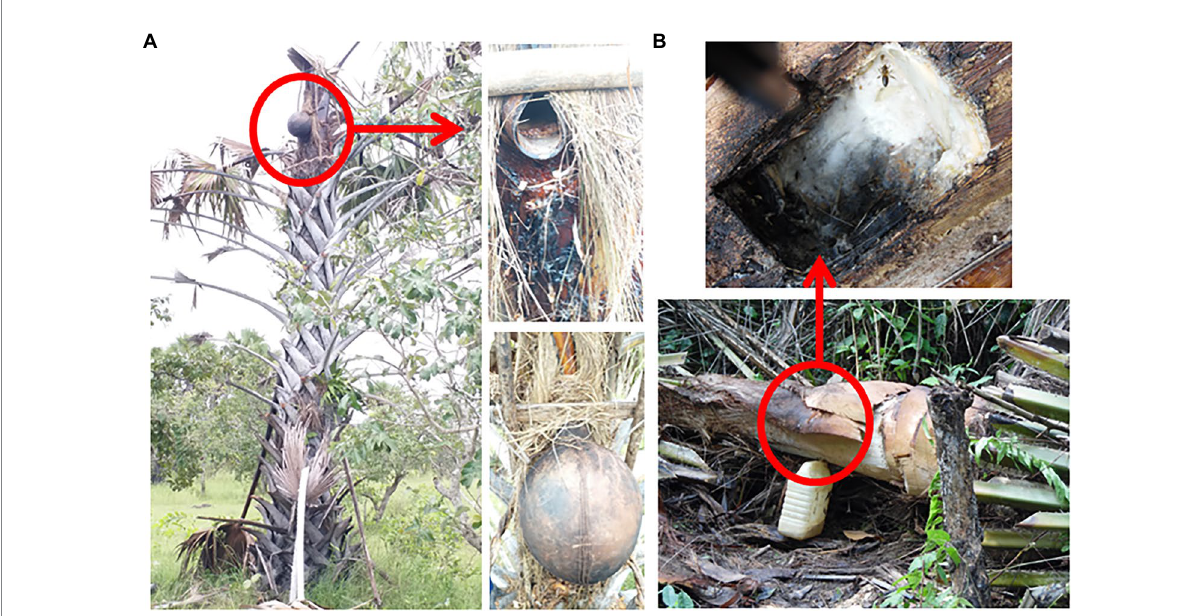
FIGURE 1 The indigenous processes of palm sap tapping practiced in Côte d’Ivoire for palm wine production from ron palm ( Borassus aethiopum ) (A) and oil palm ( Elaeis guineensis ) (B) . Perforation of the apical meristem of the tree trunk is in practice for sap tapping from ron palm, whereas the oil palm tree is uprooted before